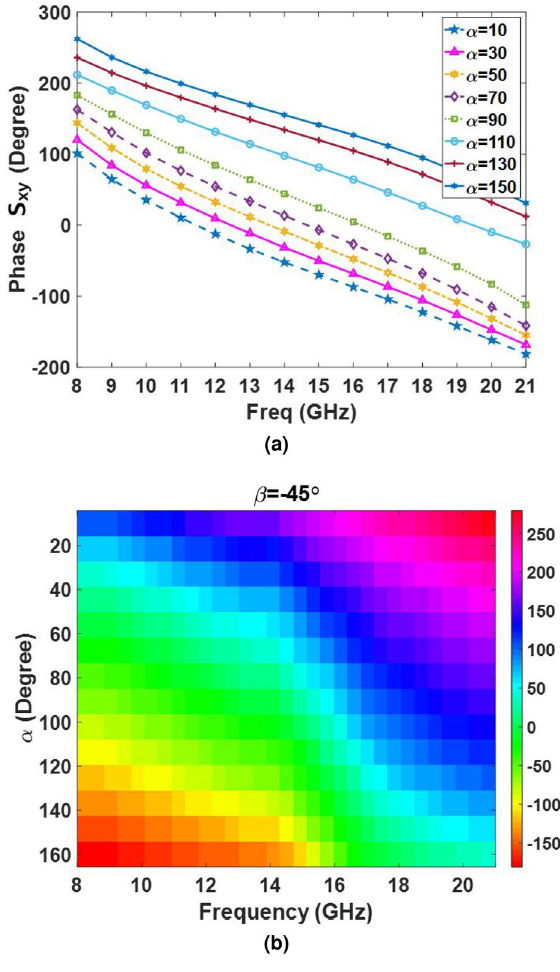
Figure 5. ( a ) and ( b ) The cross-polarized reflection coefficients versus the frequency for different values of α angles.